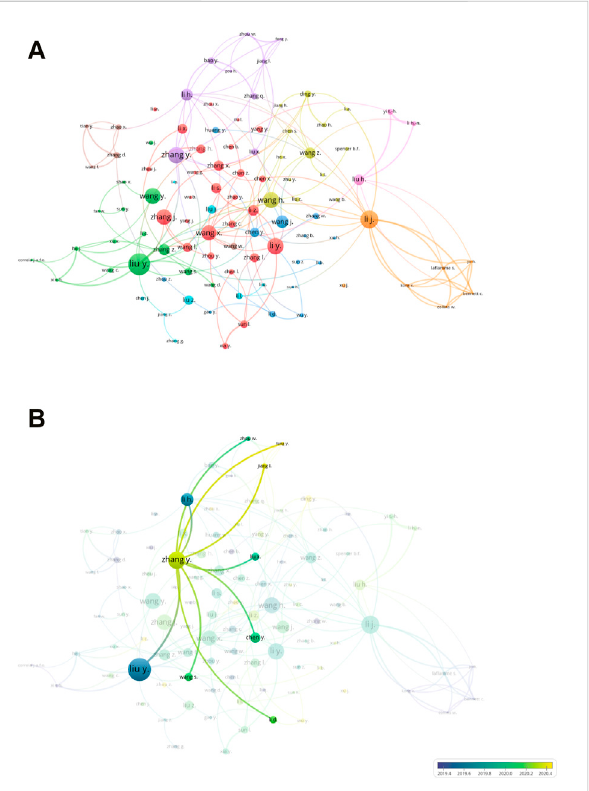
FIGURE 7 Co-authorship relationships in terms of authors: (A) Authors clusters and (B) Most recent publication averaged year per author, Zhang